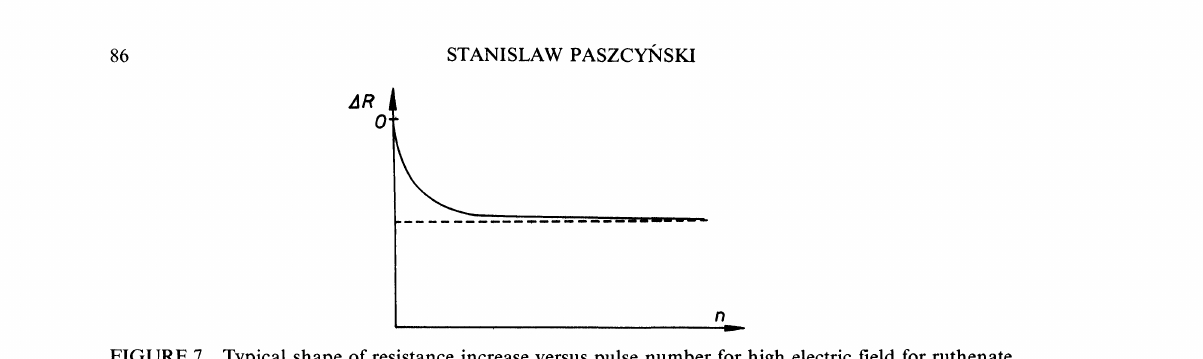
FIGURE 7 Typical shape of resistance increase versus pulse number for high electric field for ruthenate resistors with film resistivity greater than 10 rim.